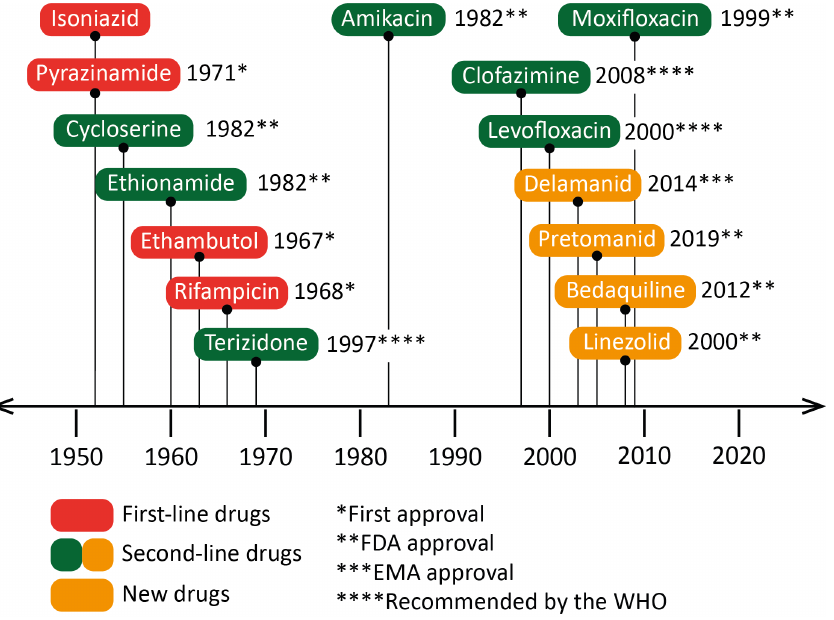
Figure 4. Dates of the first clinical trials for drugs recommended by the World Health Organization (WHO) for the treatment of tuberculosis (TB). The year of approval (or recommendation) for the use against Mycobacterium tuberculosis or against bacteria of the Mycobacterium genus is indicated next to the drug’s name. Isoniazid was accepted for prescription shortly after its first clinical trials. Some drugs, such as linezolid or moxifloxacin, were approved as broad-spectrum antibiotics, although specific clinical trials against TB occurred later. EMA: European Medicines Agency.